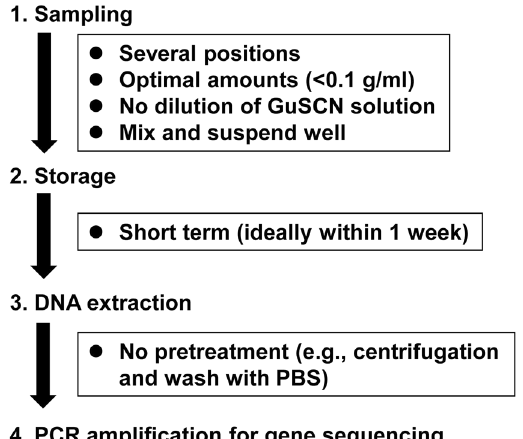
Figure 7. Schematic description of the proposed optimal protocol for 16S rRNA-based analysis of bacterial composition in fecal samples stored in GuSCN